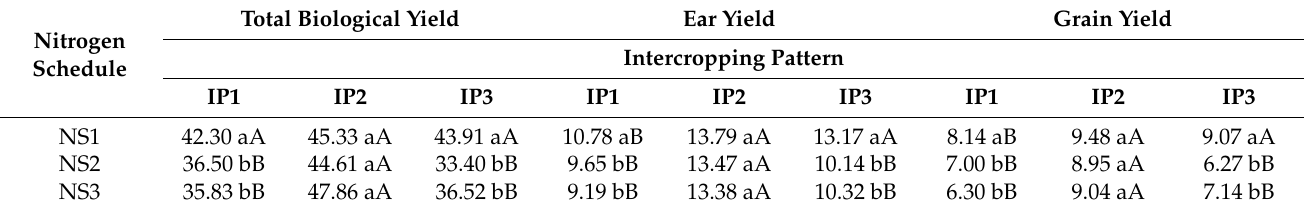
Table 3. Variations of the total biological yield, ear and grain yields (t ha − 1 ), as affected by the interaction between the intercropping pattern and nitrogen schedule combined over the two growing seasons.